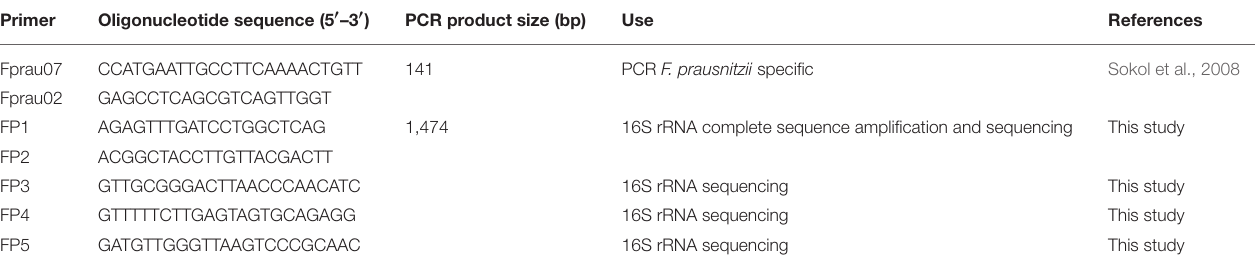
TABLE 2 | Oligonucleotides used in this study and PCR product sizes.